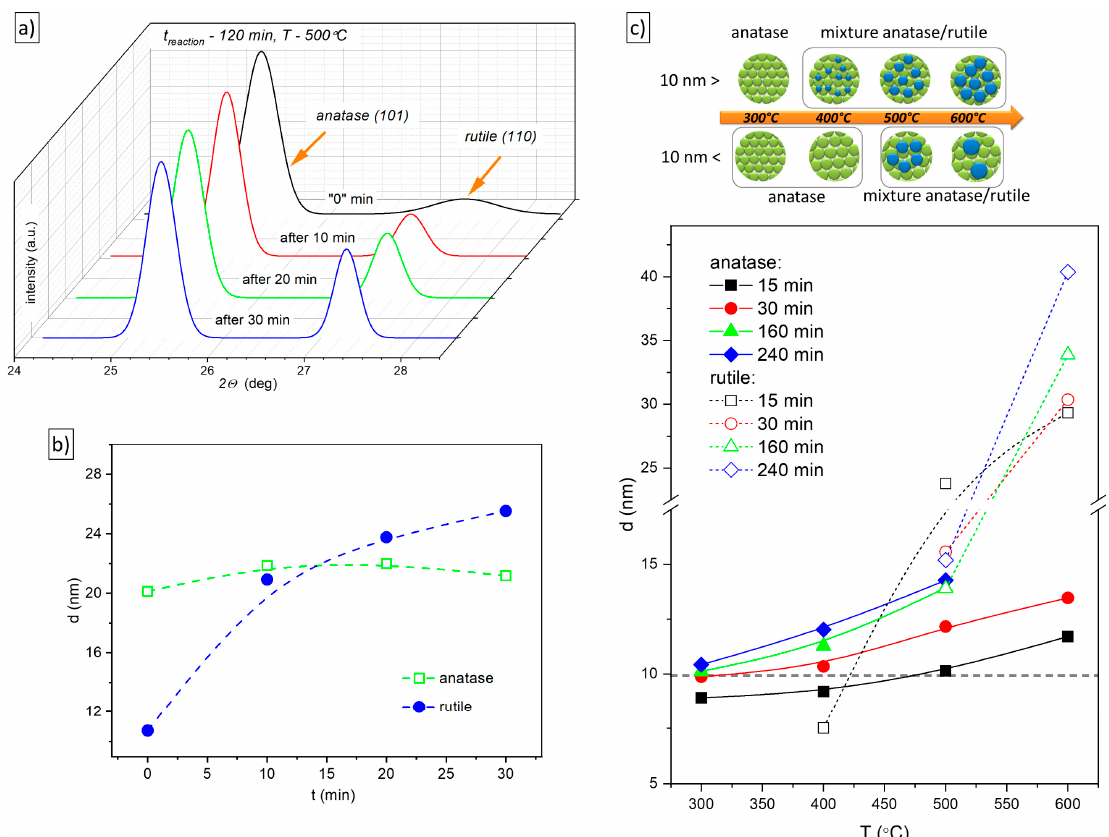
Figure 5. XRD in situ kinetic phase transition at 500°C of TiO 2 flower-like nanostructures obtained in 120 min synthesis process ( a ) with corresponding crystallite size changes ( b ). Growth of anatase and rutile crystallites as a function of the annealing temperature used, and the chemical oxidation time of the titanium foil ( c ).